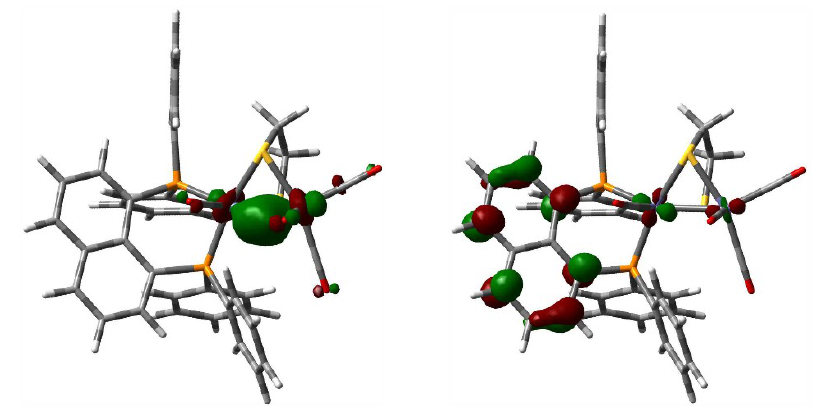
Figure 4. Plots of the HOMO (left) and LUMO (right) of [Fe 2 (CO) 4 (κ 2 -dppn)(μ-edt)] ( 3 ) as computed by DFT. Both plots were printed at an isovalue of 0.06. For the M06-optimized structure of 3 , we have utilized the Stuttgart-Dresden effective core potential and SDD basis set for the iron atoms and a 6-31G(d’) basis set for the remaining non-metal atoms.